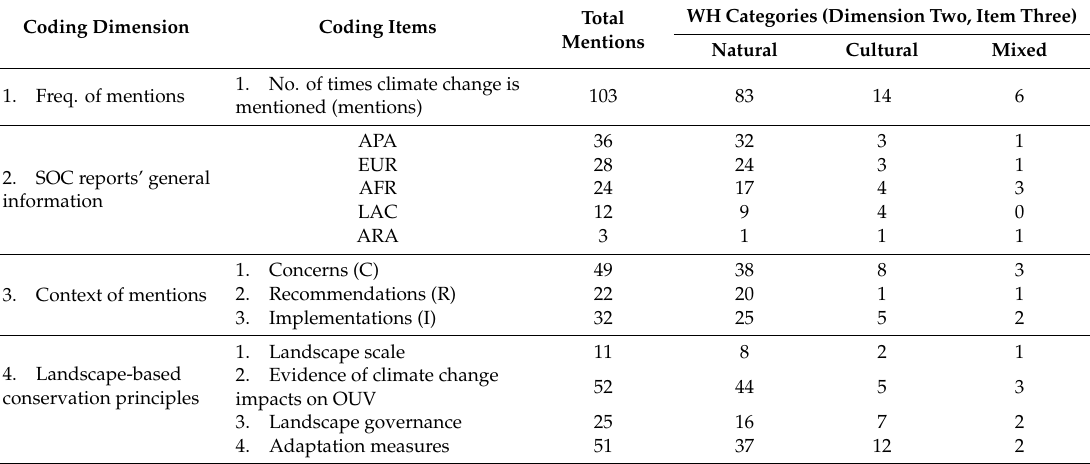
Table A1. Summary of the total number of mentions per WH category (does not include the total number of WH